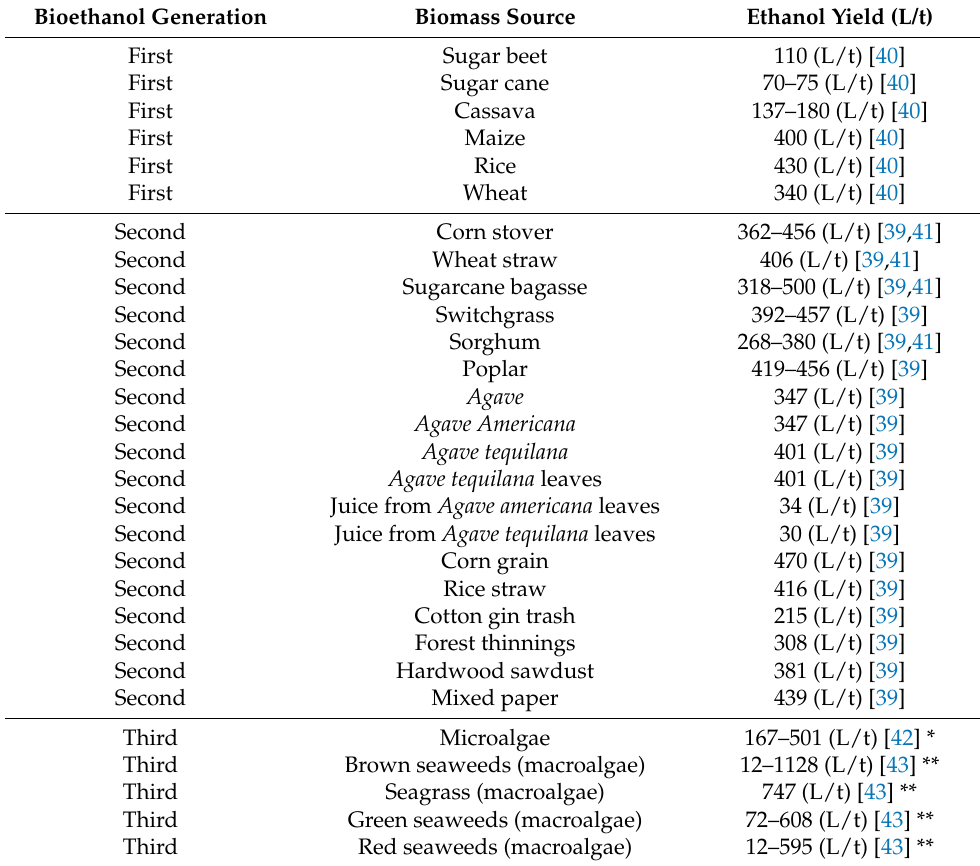
Table 1. Approximate ethanol yields from different feedstocks